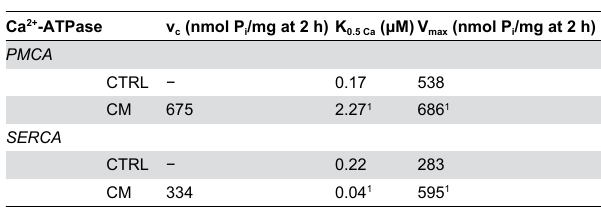
Figure 5. Ca 2+ -ATPase activity and content of Ca 2+ - handling proteins in whole homogenate of vas deferens tissue. (A) Time course of Ca 2+ -ATPase activity. The Ca 2+ - ATPase activity was assayed at the different times of incubation presented on the abscissa , starting at 30 s, using the CTRL (empty circles) and CM (filled circles) groups. Results are expressed as mean ± SEM (n = 5). The smooth curves were fitted to the experimental points using the equation P = P (1 - e -k t ), where k is the first-order rate constant and i , t i , max P is the asymptotic value of P release. (B) and (C) Ca 2+ i, max i concentration dependence of the Ca 2+ -ATPase activities in whole homogenate of vas deferens . Values were obtained for PMCA (B) and SERCA (C) activities of CTRL (empty circles) and CM (filled circles) groups. Results are expressed as mean ± SEM (n = 5). The smooth lines were adjusted to the experimental points by non-linear regression using the equations: v = V × [Ca 2+ ]/(K + [Ca 2+ ]) or v = v + V × max 0.5 Ca c max [Ca 2+ ]/(K + [Ca 2+ ]) for the CTRL and CM groups, 0.5 Ca respectively. V is the maximal hydrolysis rate, and K is max 0.5 Ca the free Ca 2+ concentration required for half-maximal activation of the CTRL activities and also represents the free Ca 2+ concentration required for half-maximal activation of the lower affinity components (above 0.01 µM) of PMCA and SERCA in the CM group. The term v represents the very high affinity c component of the Ca 2+ curve in CM. (D) (E) and (F) Contents of PMCA, SERCA2 and FKBP12 in vas deferens . Ca 2+ pumps PMCA and SERCA2 and immunophilin FKBP12 were immunodetected in whole homogenates of vas deferens from the CTRL (empty bars) and CM (black bars) groups. (D) PMCA. Upper panel: representative immunoblotting of three determinations. Lower panel: graphic representation of three immunoanalyses of different preparations. Samples from CTRL and CM were analyzed in parallel on the same gel; densitometric values were corrected for protein loading using Ponceau red and are presented as percentage of CTRL. (E) SERCA2. Upper panel: representative immunoblotting of three determinations. Lower panel: graphic representation of three immunoanalyses of different preparations. Samples were analyzed as described in (D). (F) FKBP12. Upper panel: representative immunoblotting of three determinations from different rats from the CTRL and CM groups, each of which was analyzed using recombinant FKPB12 as a parallel positive control, as shown in immunoblotting legend. Lower panel: graphic representation of three immunoanalyses of vas deferens FKPB12. *P<0.05 vs . the corresponding CTRL; NS: no statistical difference. doi: 10.1371/journal.pone.0069682.g005 PLOS ONE |